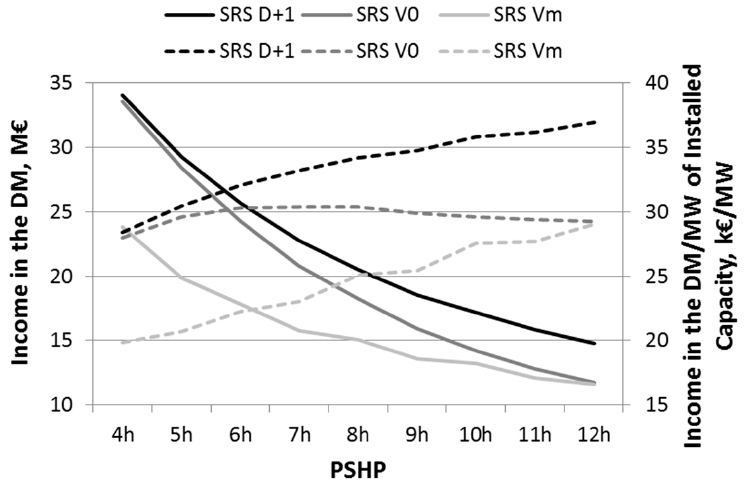
Figure 5. Annual maximum theoretical income in the DM (solid lines) and per MW of the installed capacity in generating mode (dashed lines) of each PSHP.